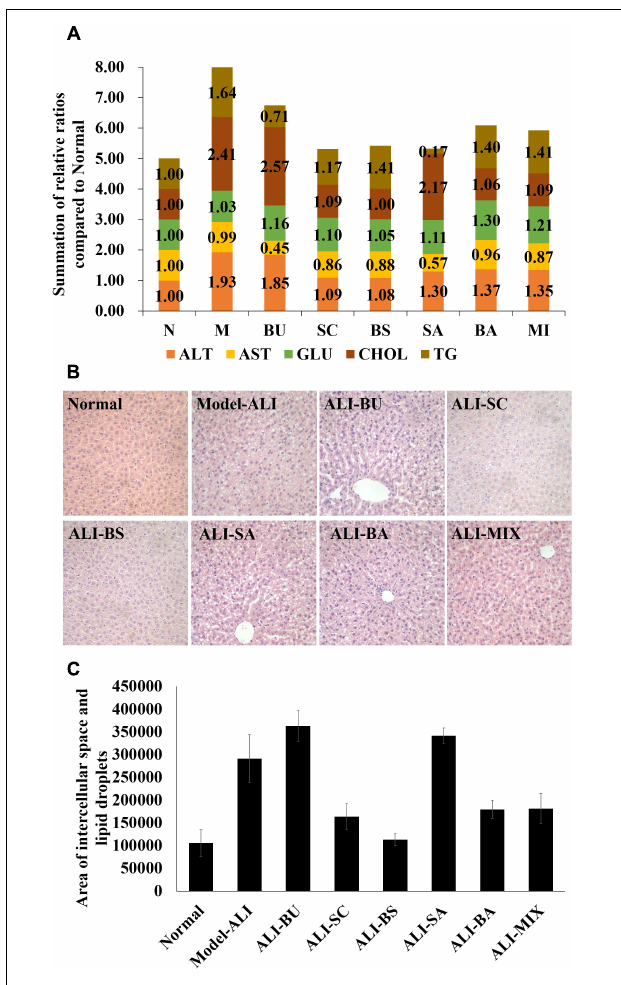
FIGURE 1 | Biochemical and histological analysis. (A) Biochemical analysis of major biomarkers for liver functions in blood of rates. The biochemical indicators of Bupleurum chinense-Scutellaria baicalensis and their composition were compared to the normal control group; (B) liver tissue histopathology (H&E staining) of every group; (C) the quantized results of liver tissue histopathology. The results were based on the area of intercellular space and lipid droplets to present liver cell swelling and lipid droplets accumulation. N: Normal control; M: Alcoholic Liver Injury Modeling; ALI: Alcoholic Liver Injury; BS: decoctions of B. chinense-S. baicalensis ; BU: decoctions of B. chinense ; SC: decoctions of S. baicalensis ; SA: water solution of Saikosaponin; BA: water solution of Baicalin; MI: the mixture water solution of Baicalin and Saikosaponin; Alanine aminotransferase (ALT), Aspartate aminotransferase (AST), Glucose (GLU), Cholesterol (CHOL), Triglyceride